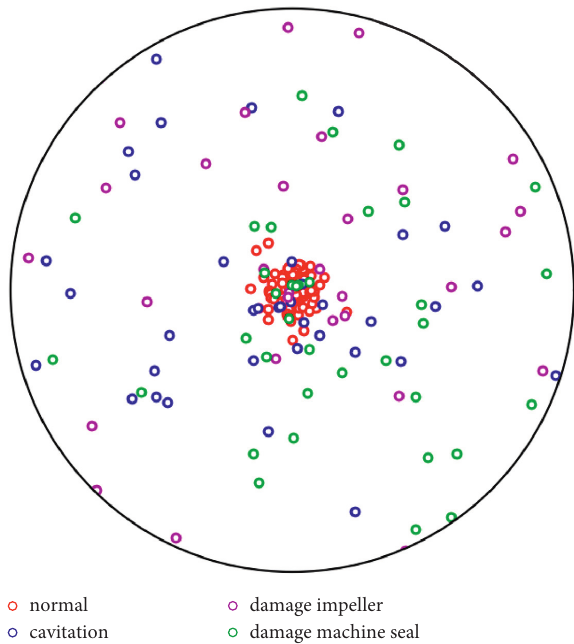
Figure 5: Schematic diagram of sample point